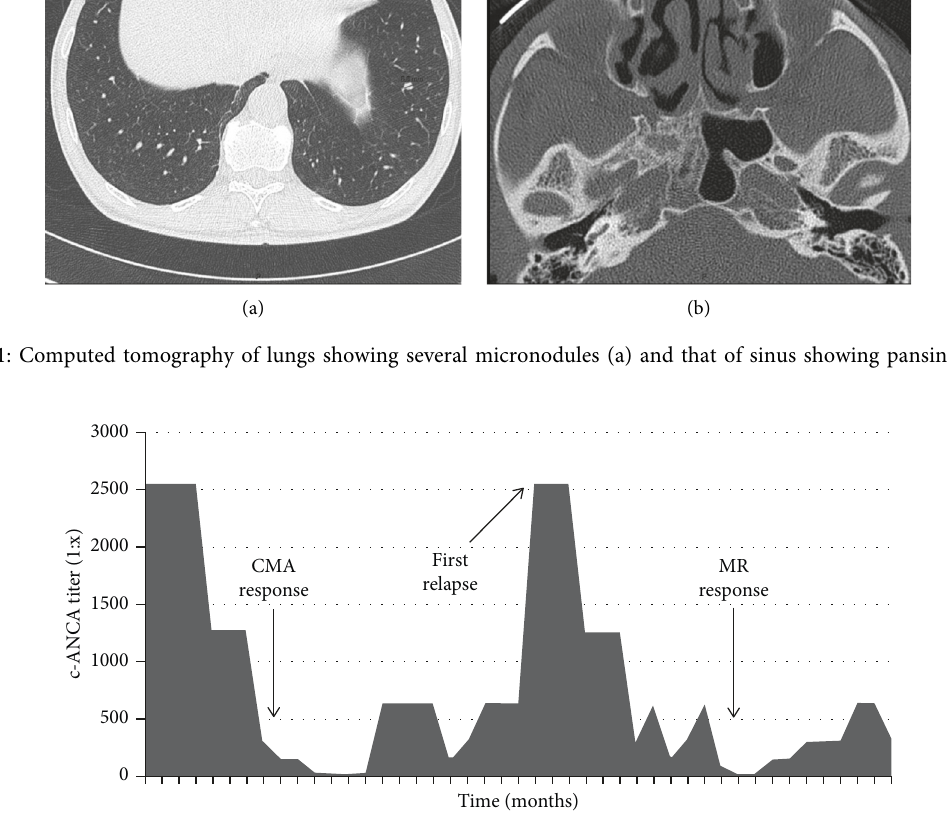
Figure 2: Evolution of c-ANCA titers over time. CMA: cyclophosphamide and methylprednisolone-based treatment followed by aza- thioprine. MR: methylprednisolone and rituximab-based treatment. This figure represents the evolution of c-ANCA titers over time. Peaks correspond to episodes of clinical relapses, and the falls correspond to improvements after